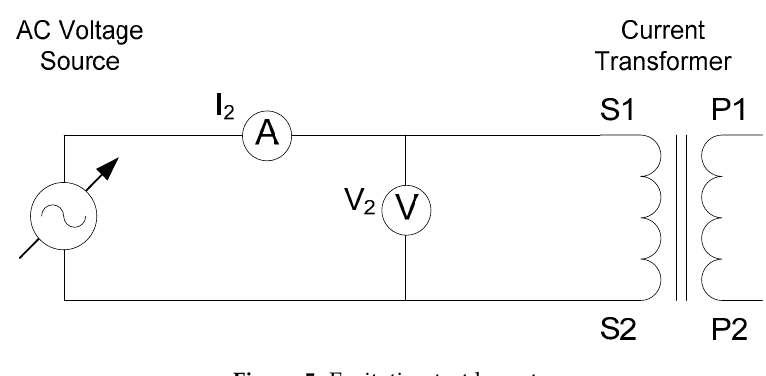
Figure 5. Excitation test layout.